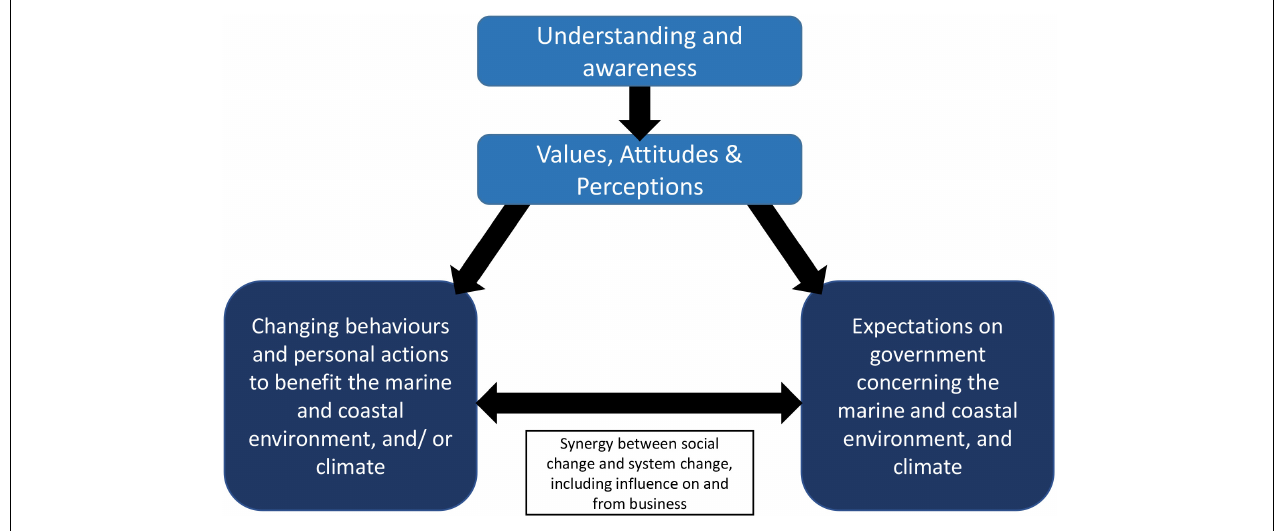
FIGURE 1 | A conceptual framework for how Ocean Literacy blends with avenues for societal shifts toward